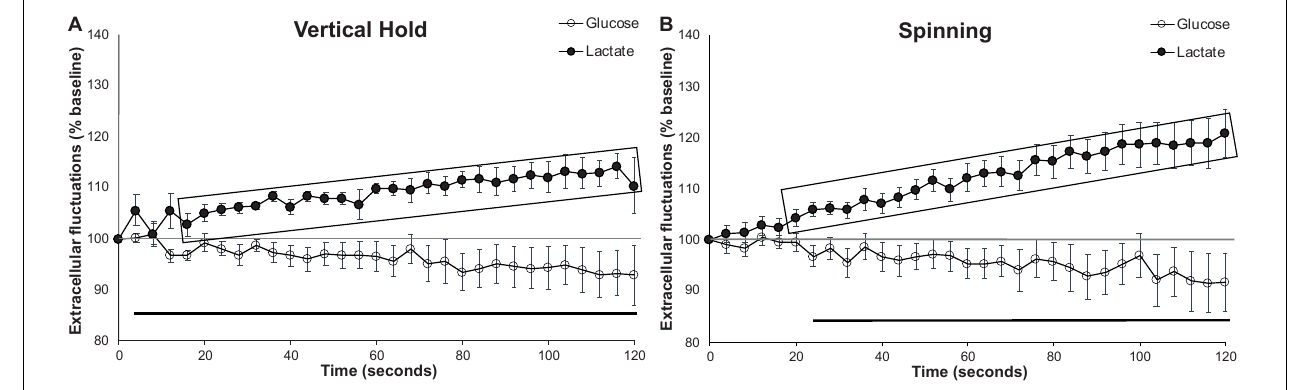
FIGURE 3 | Effortful behaviors. Average extracellular cortical glucose (open circle) or lactate (filled circle) during (A) all vertical holds events ( n = 7), (B) all spinning events ( n = 10). Gray-shaded rectangles surrounding the glucose (open circles) and lactate (filled circles) curves indicate significant differences from respective controls (120 s runs). Extracellular glucose and lactate did not significantly differ between the vertical hold and spinning conditions. Horizontal lines below the data indicates significant ( p < 0.05) differences from baseline for both extracellular glucose (thin line) and lactate (thick line). The mid-graph gray line shows baseline (100%) value. Gray-shaded rectangles surrounding the glucose and lactate curves indicate significant differences from the running wheel (120 s), for both extracellular glucose (open circle) and lactate (filled circle).